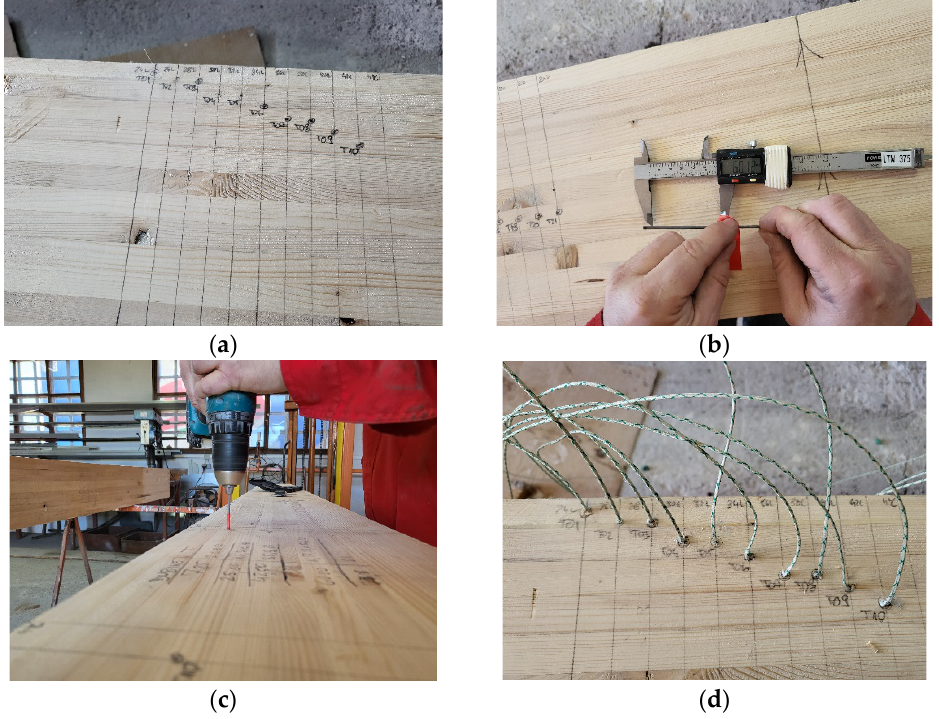
Figure 11. Thermocouple installation process: ( a ) marking the beam; ( b ) measuring and marking the drill; ( c ) hole drilling; ( d ) installation of the thermocouples.